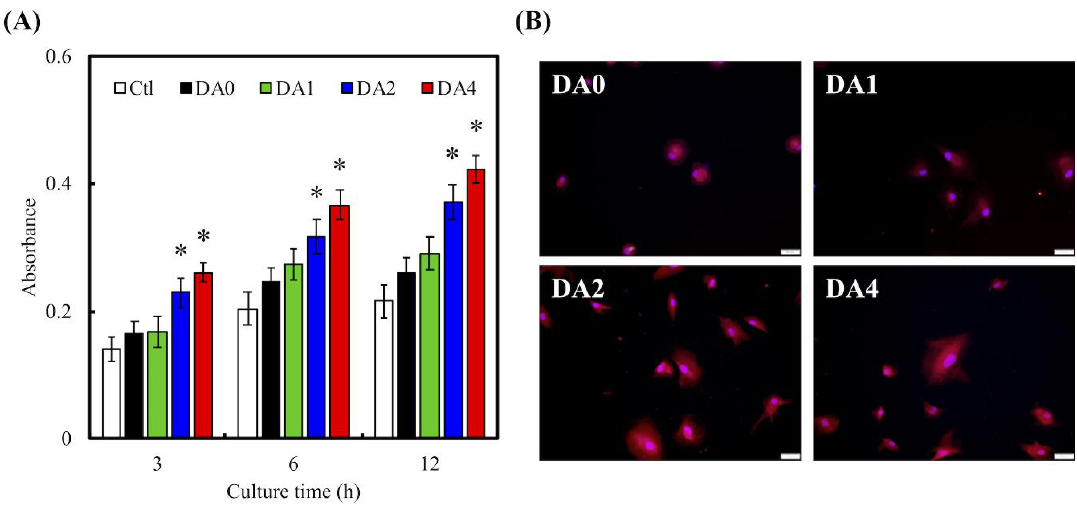
Figure 6. ( A ) PrestoBlue and ( B ) immunofluorescence of Wharton Jelly’s mesenchymal stem cells (WJMSCs) cultured with various specimens for different time points. “*” indicates a significant difference ( p < 0.05) compared to DA0. The scale bar is 50 µm.